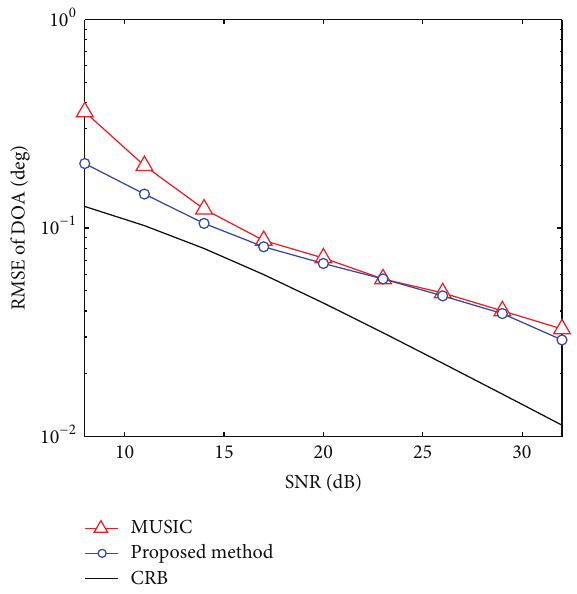
Figure 8: RMSE of the DOA for the weak source versus the SNR of the weak source, where the strong source is located at (𝜃 1 ,𝛾 1 ) = (3 ∘ , 30 ∘ ) with SWR = 20 dB and the weak source is located at , 𝛾 ) = (7 ∘ ,35 ∘ ) (𝜃 2 2